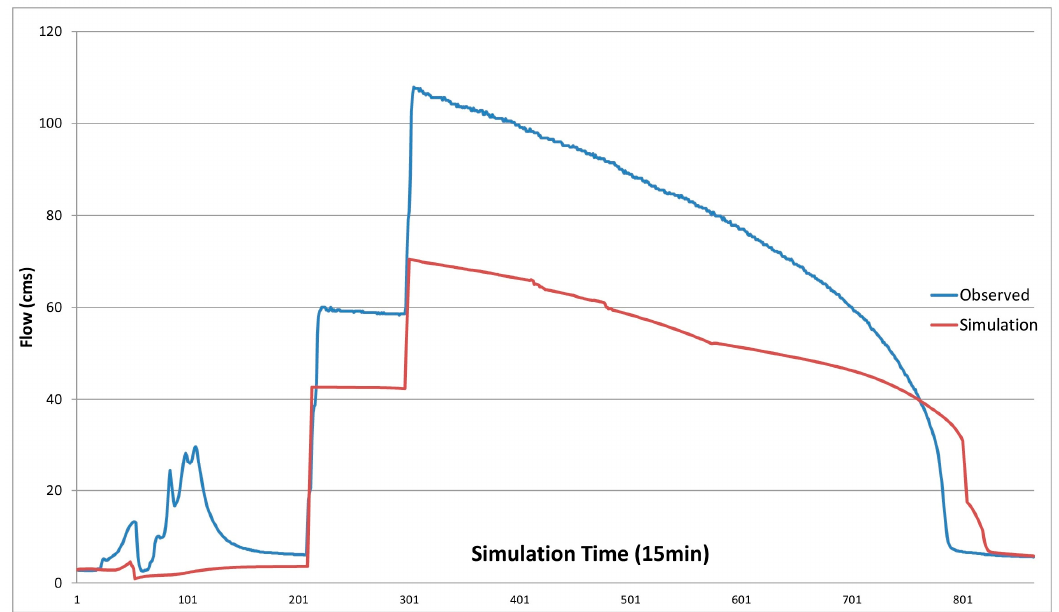
Figure 7. Model simulated dam output streamflow validated against observations from USGS station (01206900) Naugatuck River at Thomaston, CT, U.S.A.